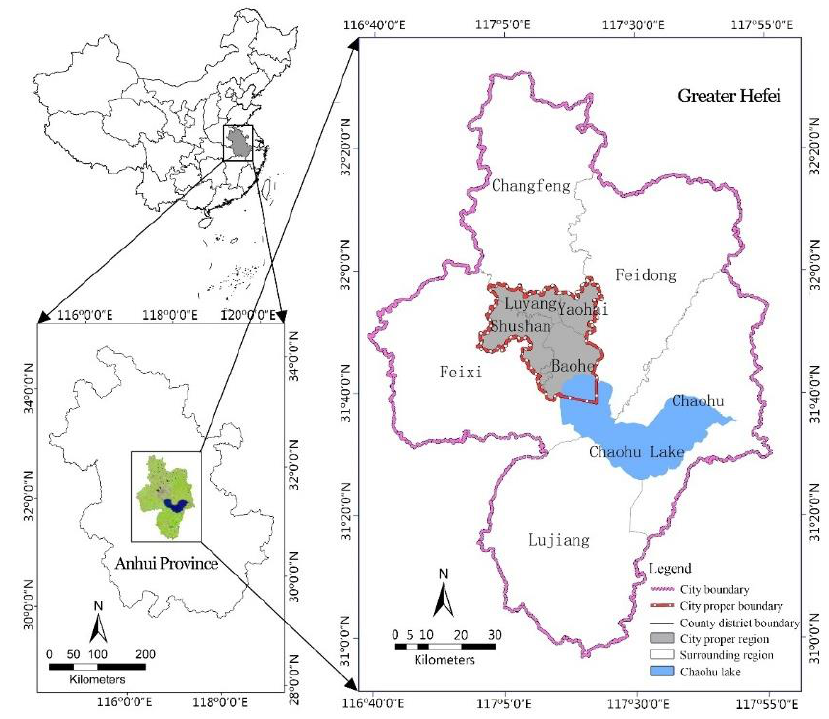
Figure 1. Location of the study region.